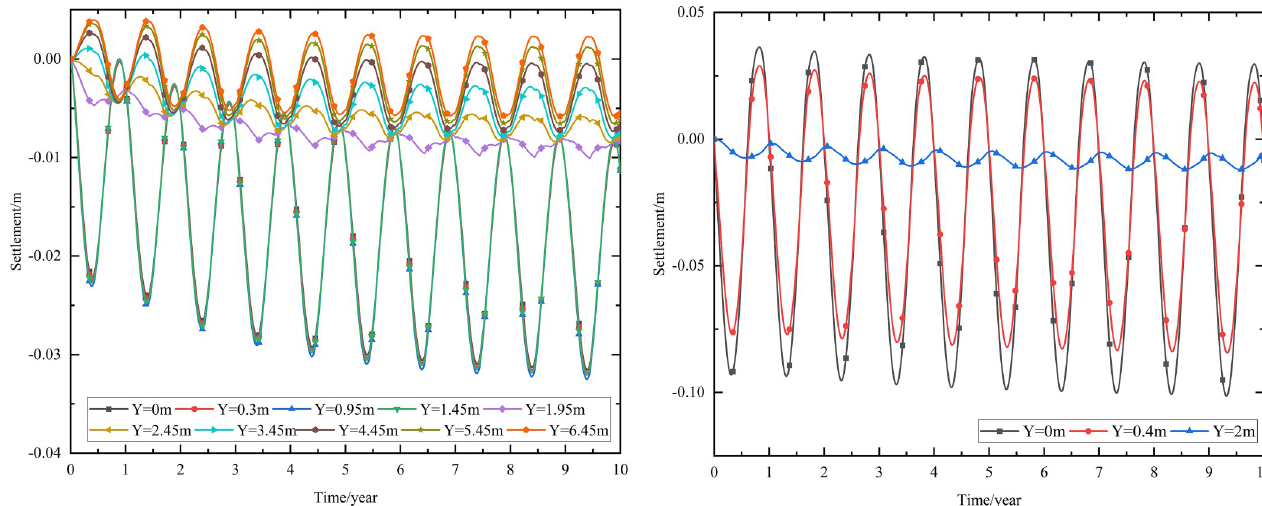
Fig 11. Settlement-time curves at the (a) pavement center and (b) natural surface